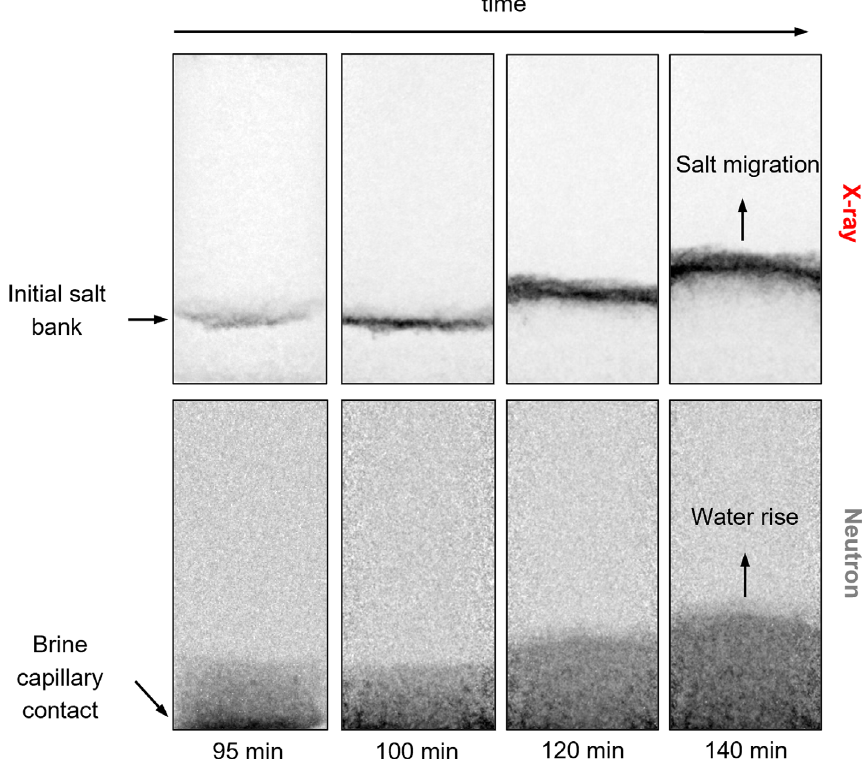
Fig. 9. 2D projections during the salt accumulation. Gas is injected from the top. On the X-ray projections, darker shades suggest a salt bank position. On the Neutron projections, darker shades suggest higher water